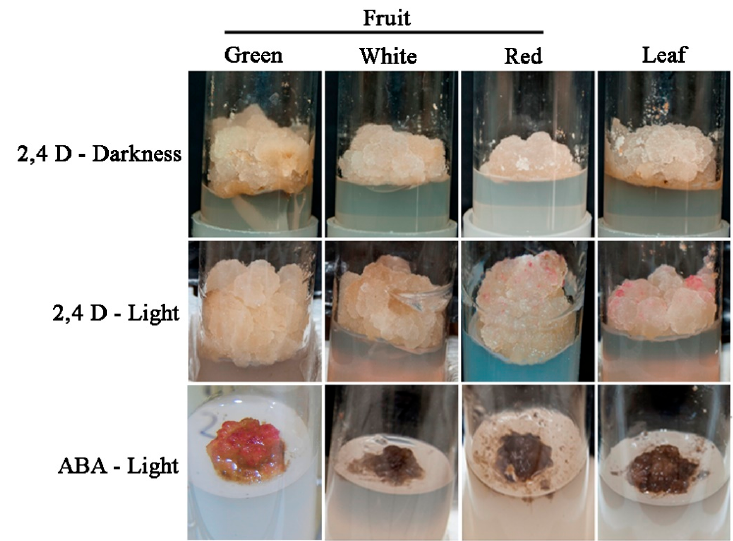
Figure 2. Aspect of calli obtained from leaf and fruit at different developmental stages growing in N 30 K medium supplemented with 11.3 µM 2,4-Dichlorophenoxyacetic acid (2,4-D) in darkness (2,4 D-darkness), the same medium under a 16 h photoperiod at 40 µmol·m − 2 ·s − 1 (2,4-D light) or N 30 K medium with 1 µM abscisic acid (ABA) under light conditions (ABA-light). Pictures were taken after 4 weeks of culture in the presence of 2,4-D and 2 weeks in the case of ABA.